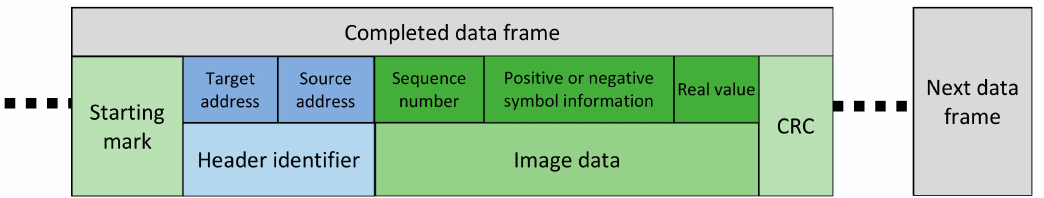
Figure 4. The structure of image data